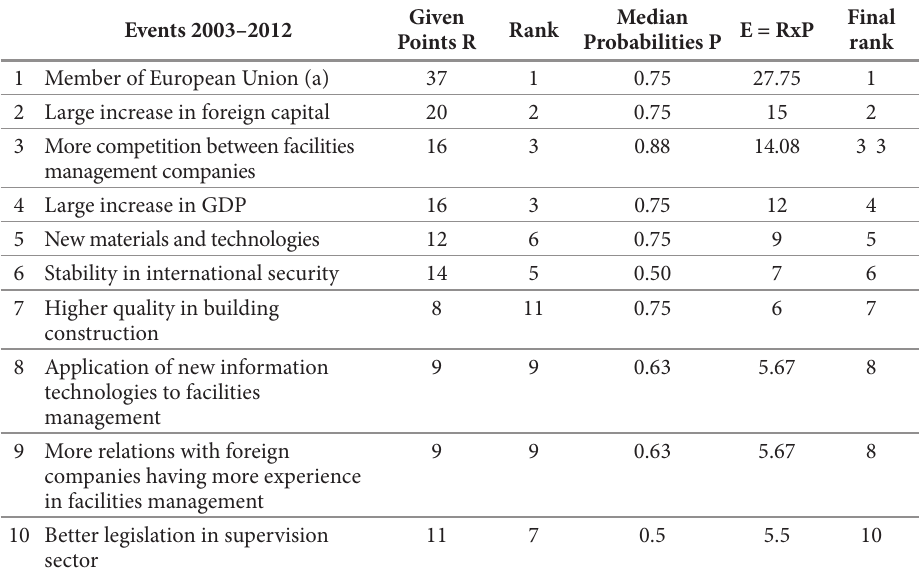
Table A1. Important Events influencing the Business Outlook of the Facilities Sector of Lithuania over the period 2003–2012 Given Events 2003–2012 Points